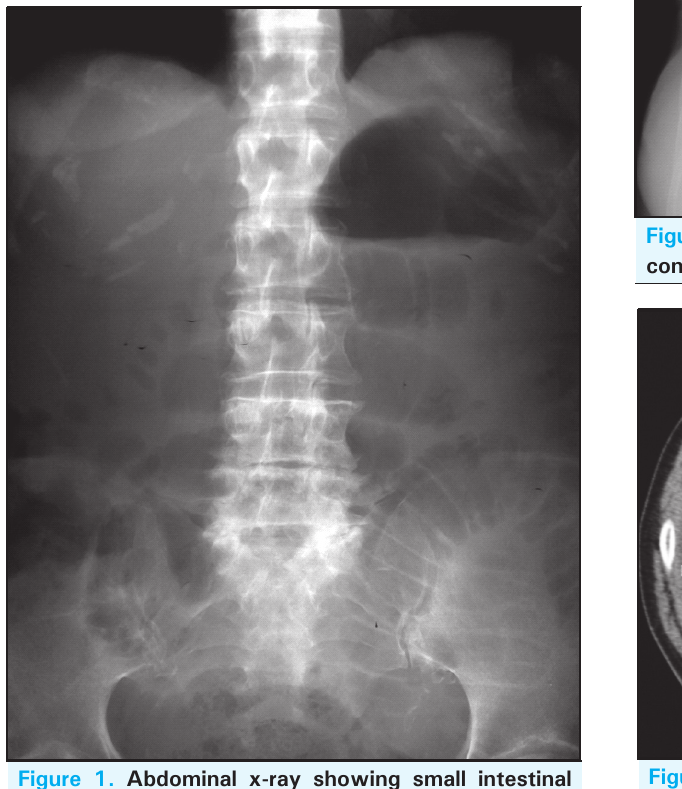
Figure 1. Abdominal x-ray showing small intestinal